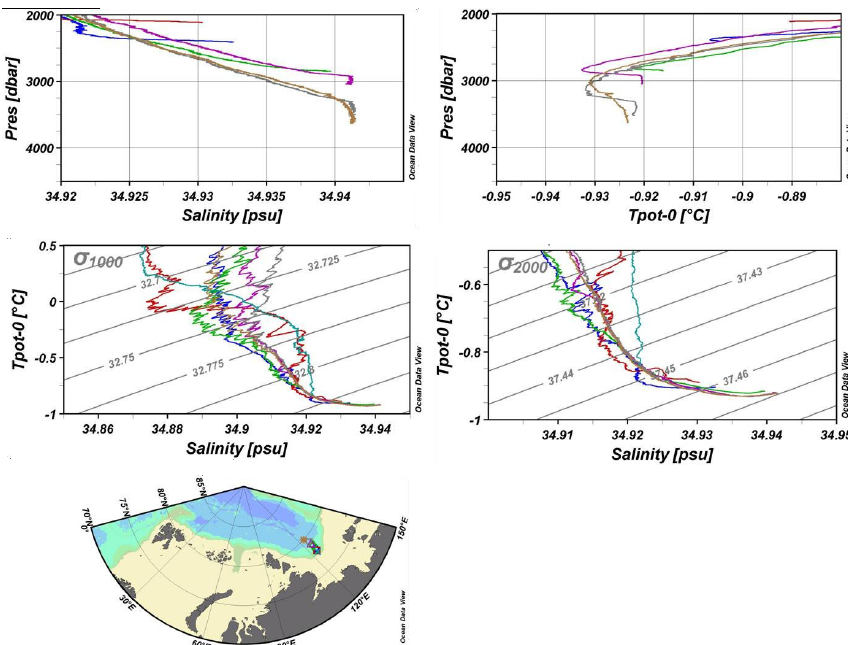
Fig. 19 . Profiles of salinity and potential temperature, and θS curves from SPACE section 4 north of the Laptev Sea. Here the slope of the deeper part of the θS curves has become more perpendicular to the isopycnals, indicating both a salinity reduction due to the Barents Sea inflow and a deeper salinity increase due to slope convection and entraining, saline and dense plumes bringing heat and salt downwards. Bottom water with increasing temperature and salinity with depth are observed at the slope between 2000m and 3500m (blue, green and magenta